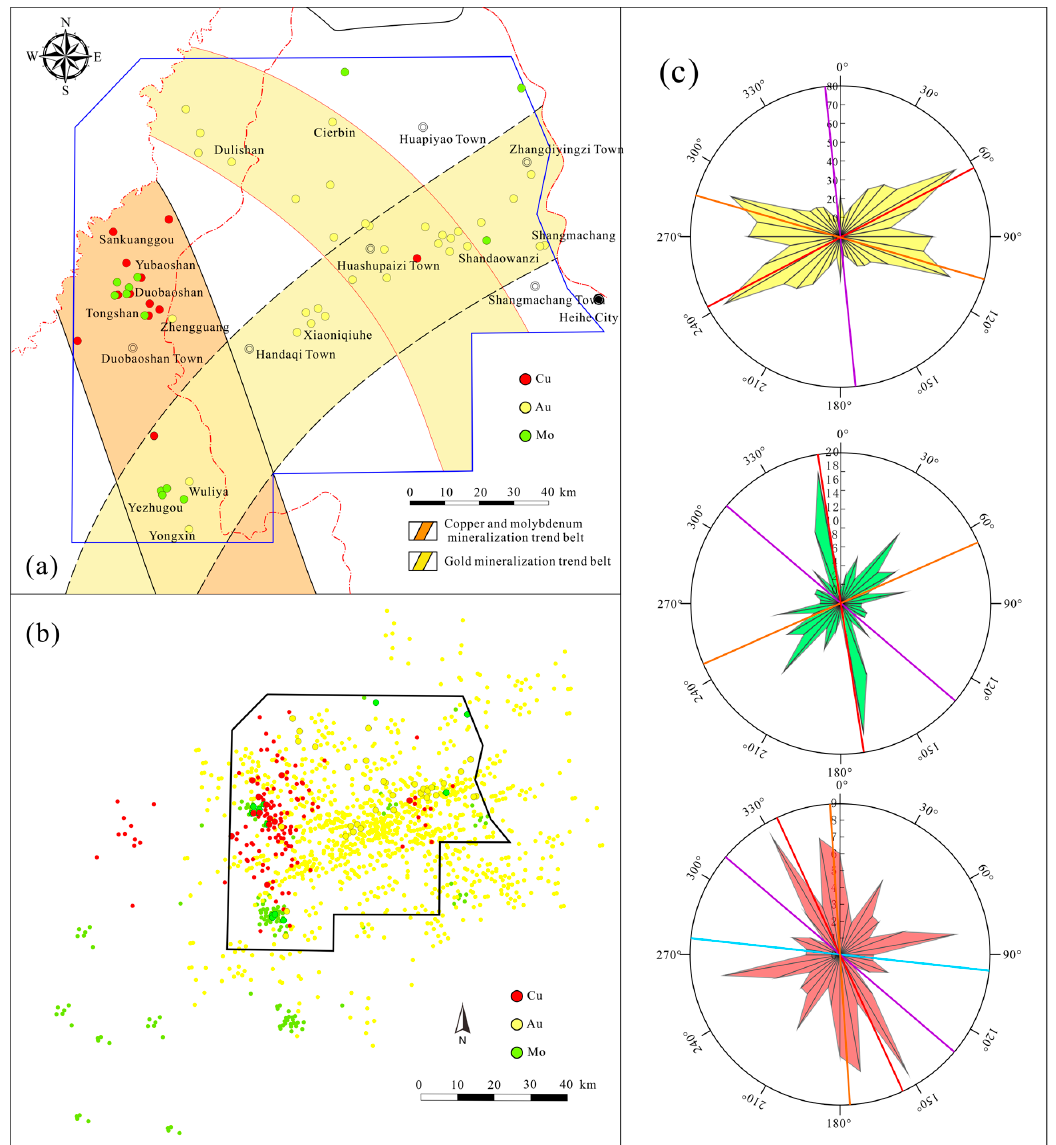
Figure 9. Fry analysis of ore distribution in the study area. ( a ) Main mineral position distribution map; ( b ) Fry analysis map; ( c ) rose chart of metal mineralization trend (yellow represents gold, green represents molybdenum, and red represents copper).